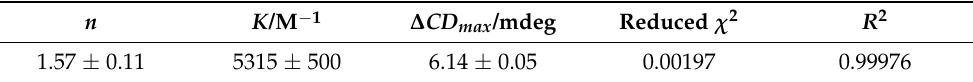
Figure 6. The change in circular dichroism intensity ( ∆ CD) of SRT at 274 nm as a function of RM β CD concentration. The red solid line represents the best fit of Equation (2) to the experimental results presented as the black points and the parameters from fitting calculations are placed in Table 2. Table 2. Stoichiometry coefficient of binding ( n ), binding constant ( K ) and maximum change in circular dichroism intensity ( Δ CD max ) together with reduced χ 2 and R 2 values for complex formation of sertraline hydrochloride with randomly methylated β -cyclodextrin molecules obtained from CD results at 274 nm.